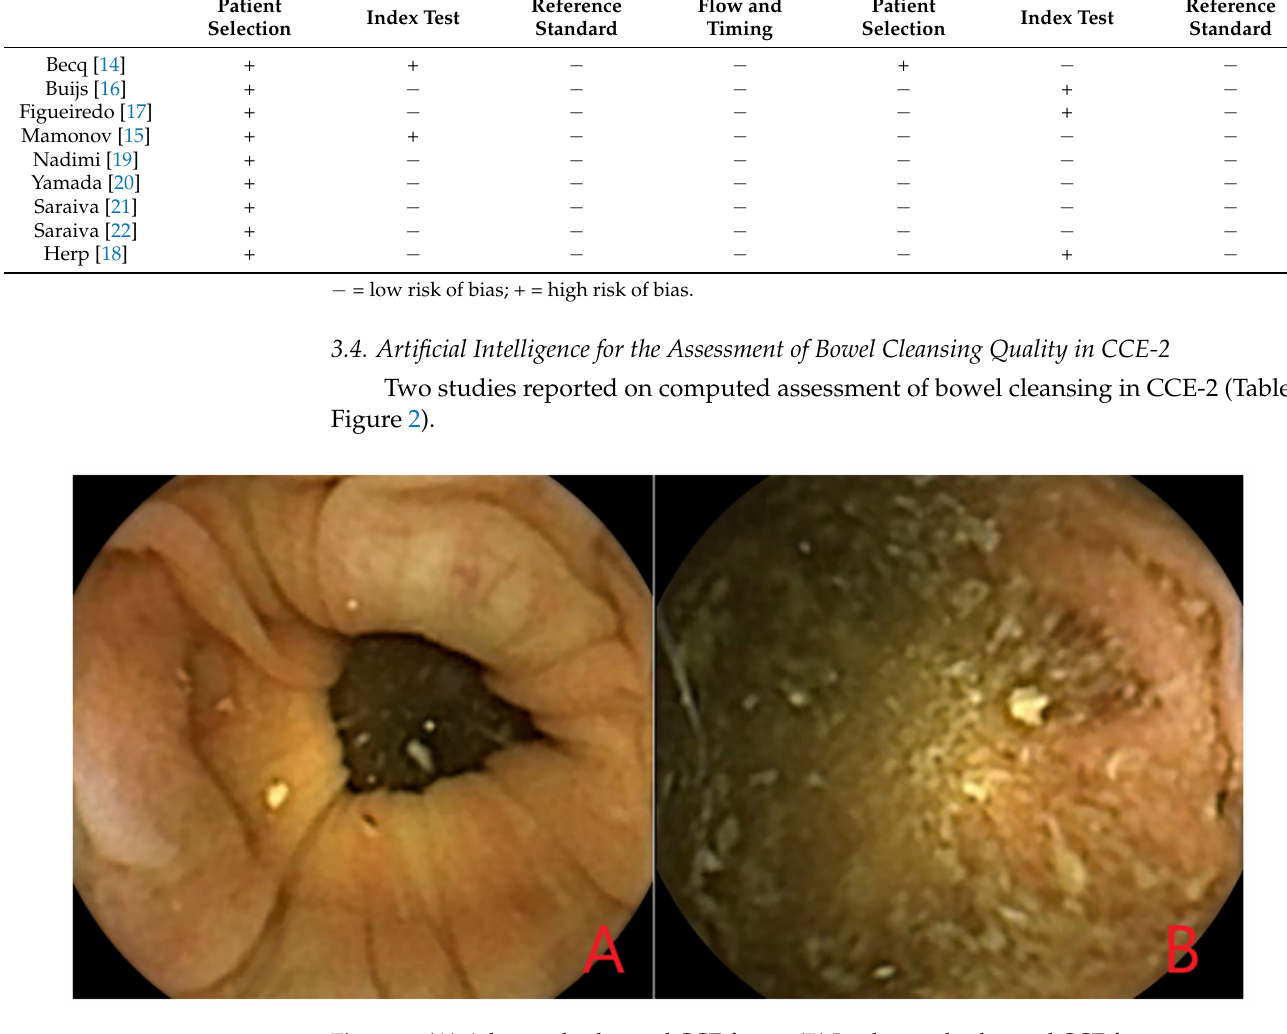
Figure 2. ( A ) Adequately cleansed CCE frame; ( B ) Inadequately cleansed CCE